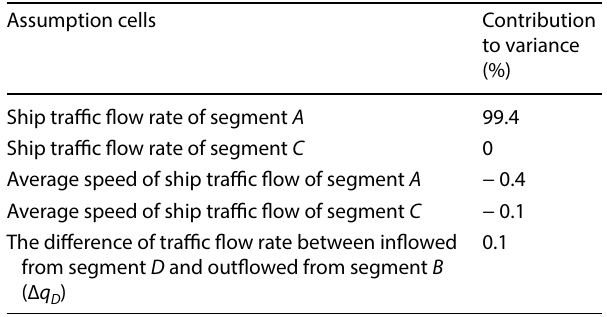
Table 10 Sensitivity analysis of the total number of ships affected ( T